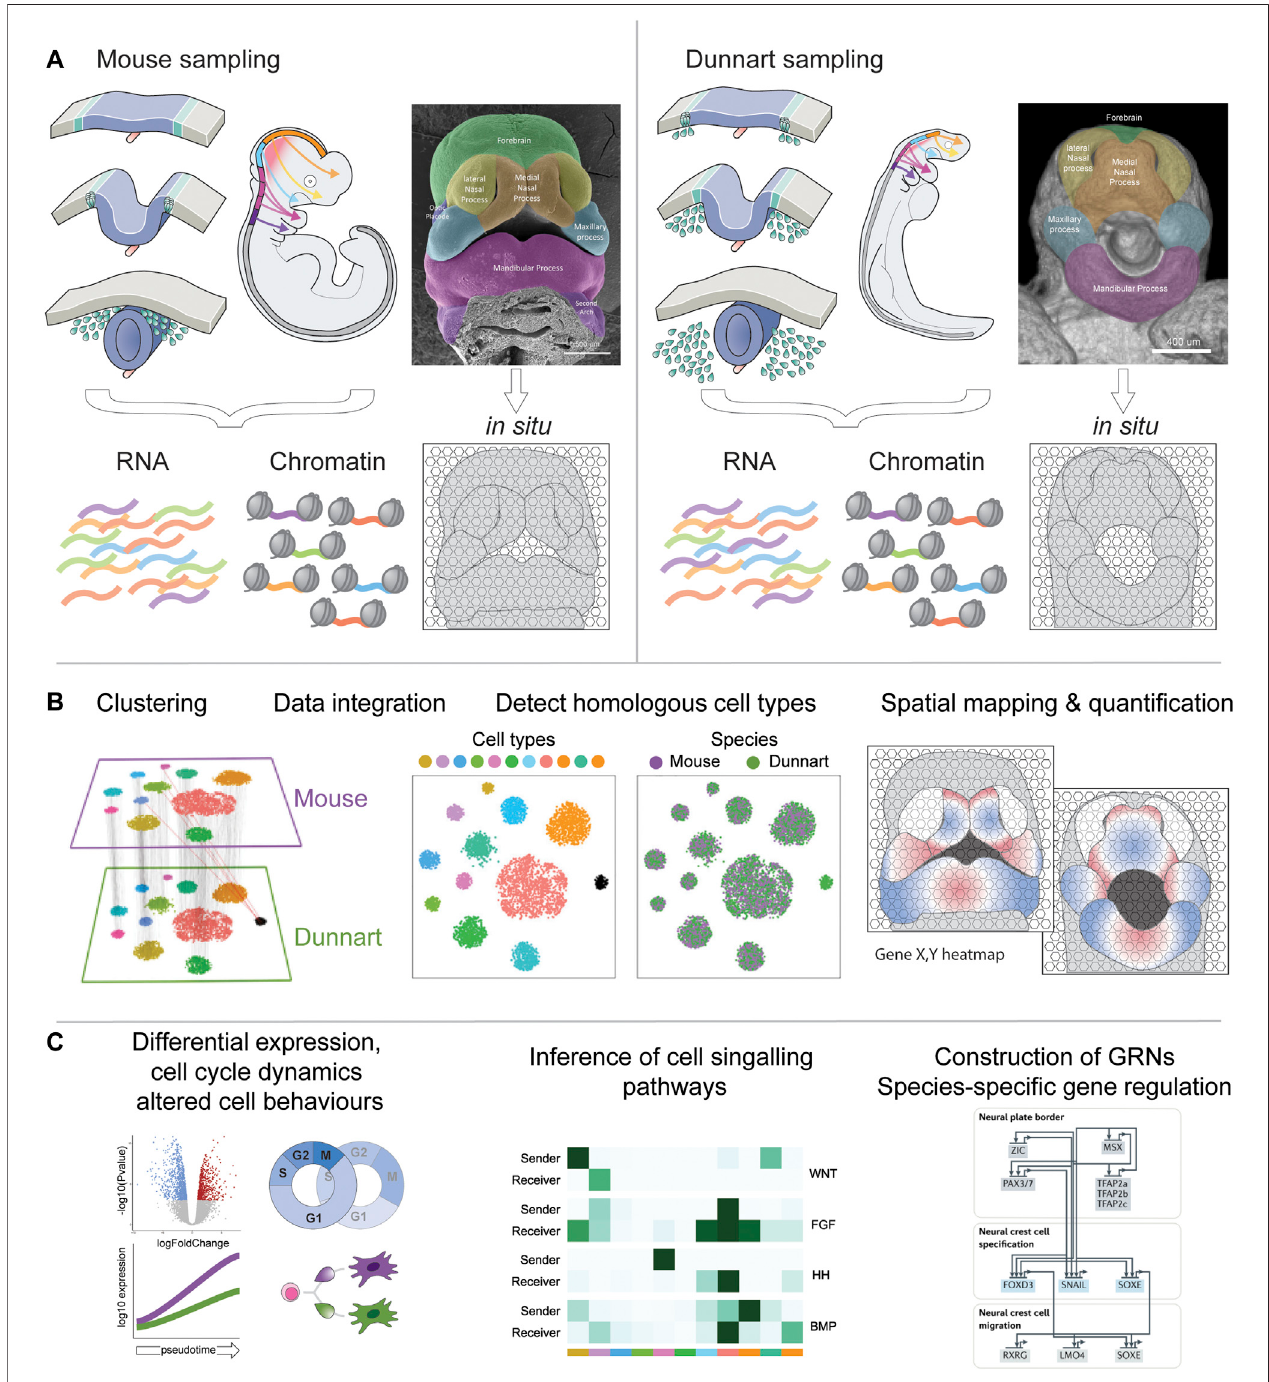
FIGURE 2 | Work fl ow for comparative craniofacial single-cell multiomics. (A) Single cells can be isolated from dunnart and mouse NCCs and developing craniofacialprominencesformultiplexedisolationandsequencingofRNAandopenchromatin.Facialtissuesectionscanbeprocessedfor insitu spatialtranscriptomics or MERFISH (Xia et al., 2019). Single-cell RNA and ATAC-seq data can be readily integrated using pipelines such as Seurat (Butler et al., 2018). (B) Dunnart and mouse datasetscanbeindividuallyclusteredorintegratedtogenerateanatlasofhomologouscelltypepopulations — adaptedfrom(Stuartetal.,2019).Celltranscriptomic and epigenetic pro fi les can be furthermapped back totheir spatial organization inthe embryo. (C) Thecombination ofthese methods allows sophisticateddownstream work fl ows to examine differential expression between species-speci fi c clusters (pseudobulk) or cell lineage differentiation (pseudotime), inference of cell-cell signalling relationships (Jin et al., 2021), or construction of GRNs and species-speci fi c patterns of gene regulation (Martik and Bronner, 2021).